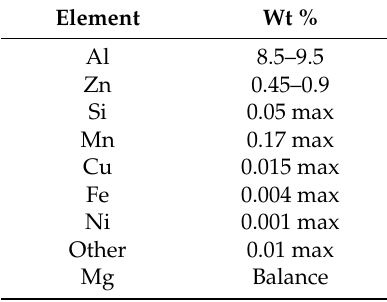
Table 2. ChemicalcompositionofmagnesiumalloyAZ91D.Reproducedfrom[14].